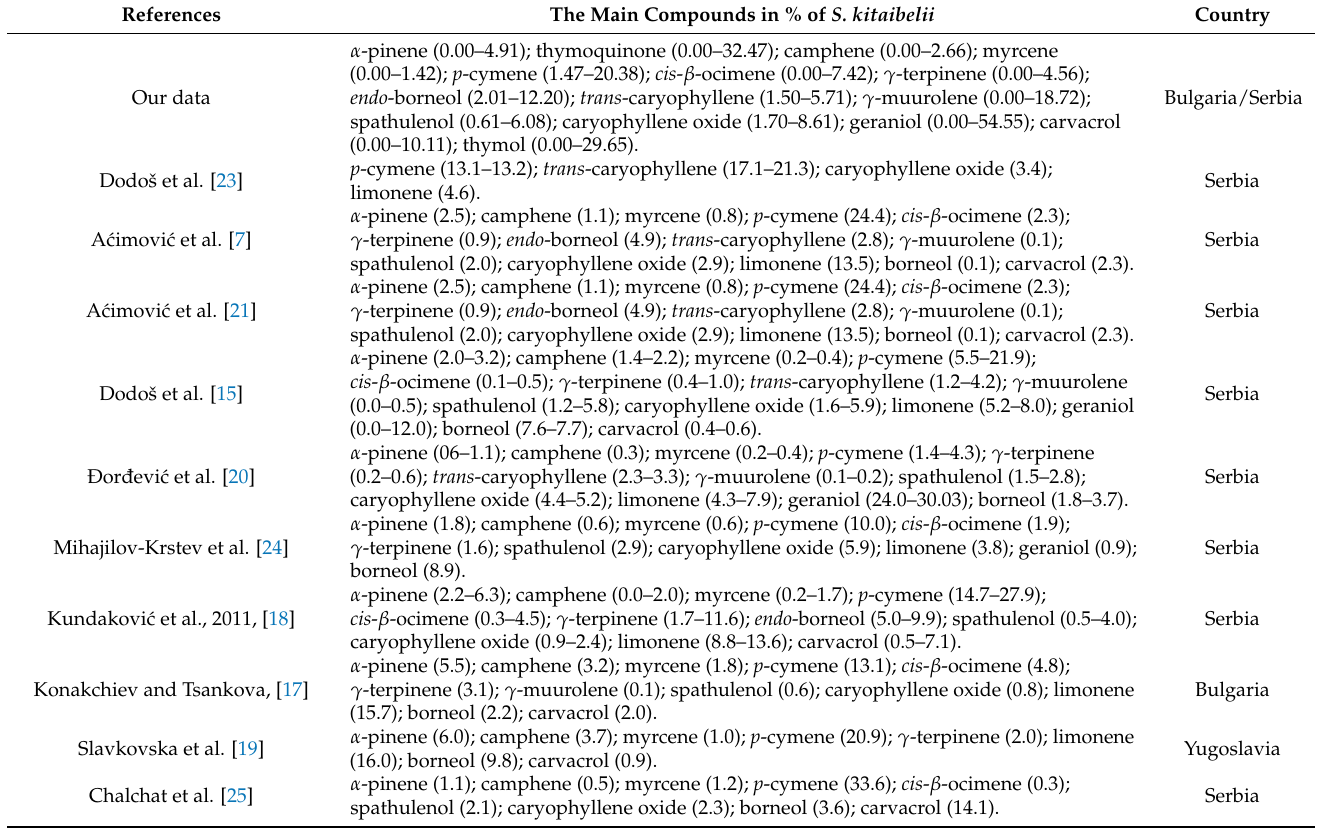
Table 1. The main compounds of essential oils of this study and literature reports on S. kitaibelii . The Main Compounds in % of S. kitaibelii